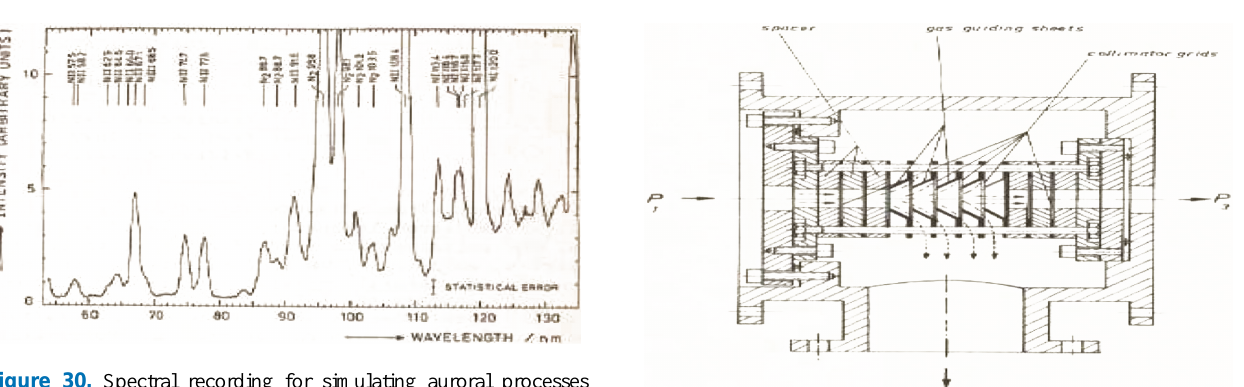
Figure 30. Spectral recording for simulating auroral processes of molecular nitrogen (Fischer et al., 1980; copyright permission granted by Wiley publishing).